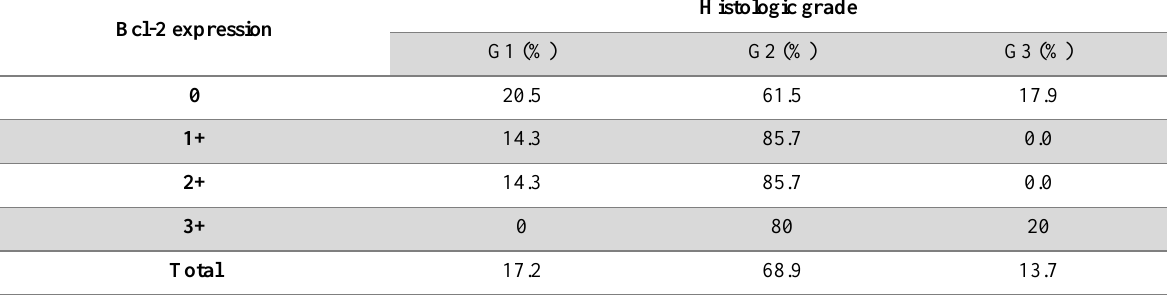
Table 3. Bcl-2 expression with respect to tumor stage